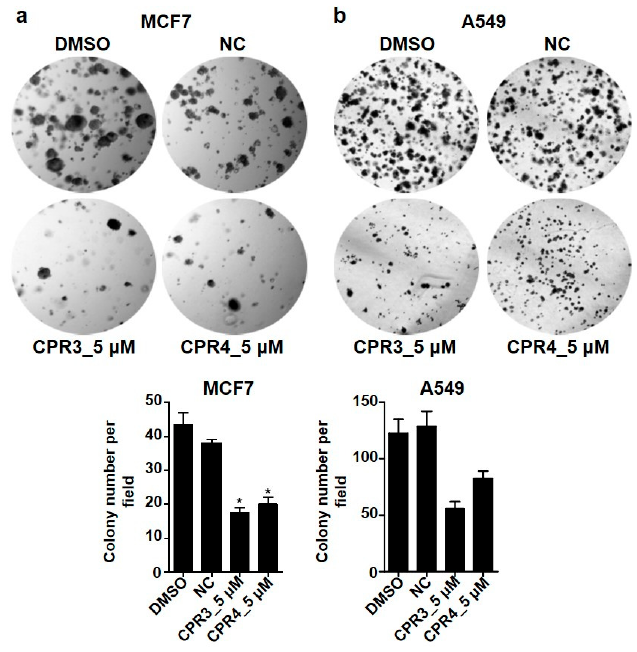
Figure 6. Soft agar colony formation images after treatment with CPR3 or CPR4 in both MCF7 ( a ) and A549 ( b ) cells. CPR3 or CPR4 was treated at 5 µ M of concentration, followed by an incubation period of 2 weeks. The formed colonies were stained with 0.1% crystal violet and were detected on a bright field microscopy. * P ≤ 0.05, as determined by Student’s t-test.